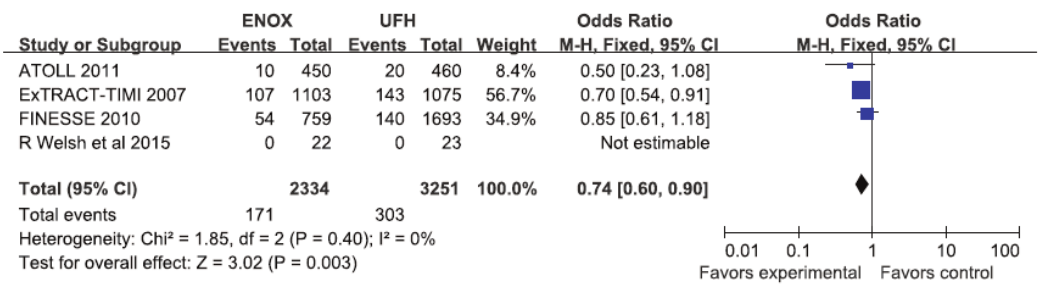
Figure 3: Fixed-effect meta-analysis for myocardial infarction.